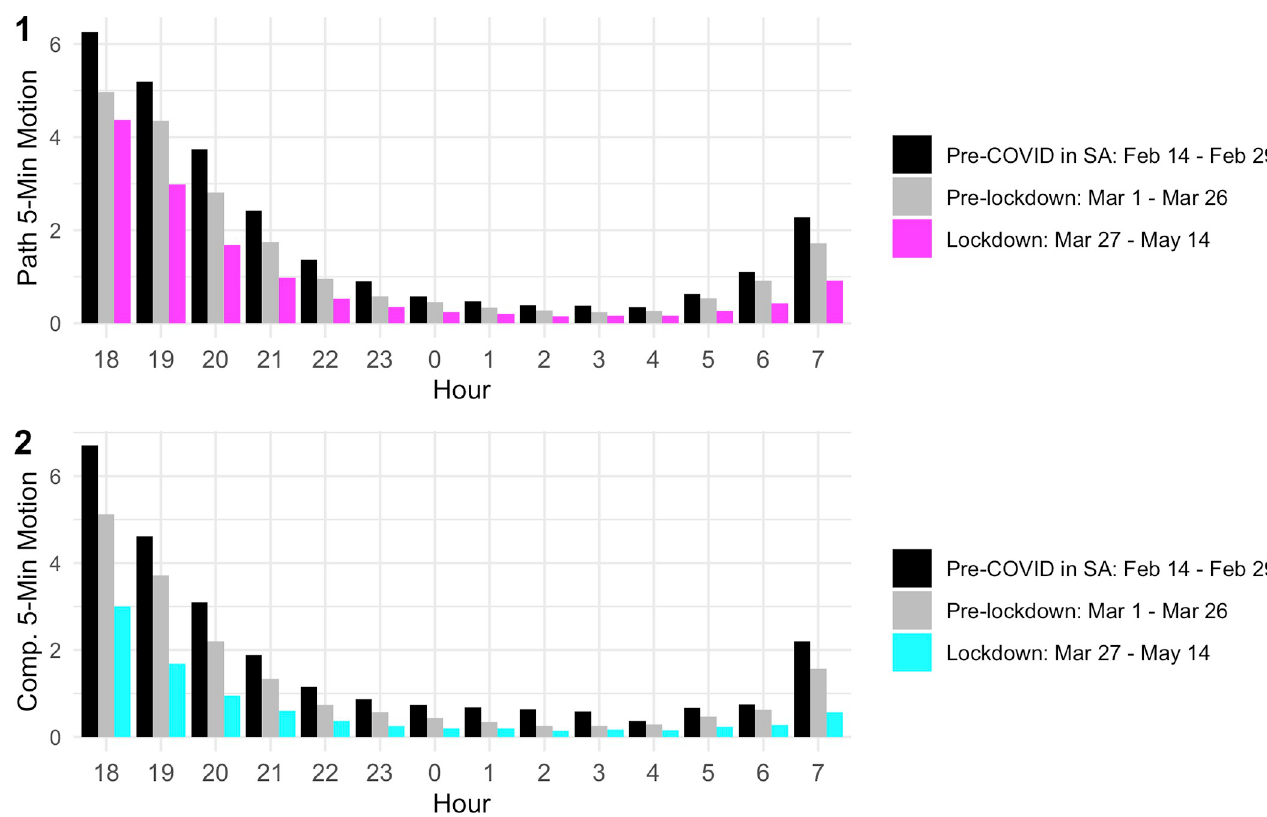
Fig 5. Average five-minute motion by hour. The panels show the average five-minute motion by hour in the dataset for the month of February, the month of March before lockdown, and for the lockdown period for paths (1) and compounds (2), respectively. Table of results with February included separately available from the authors upon